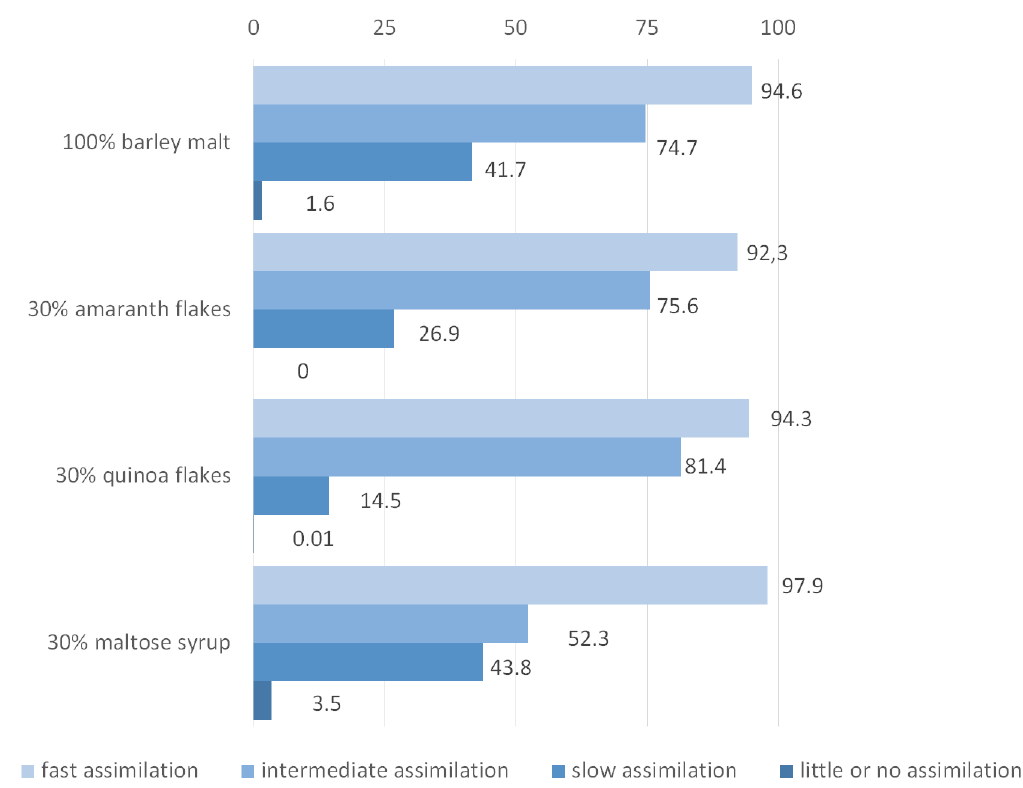
Figure 3. The assimilation [%] of the individual groups of amino acids by yeast during the fermentation, compared to the results obtained for amino acids in worts.